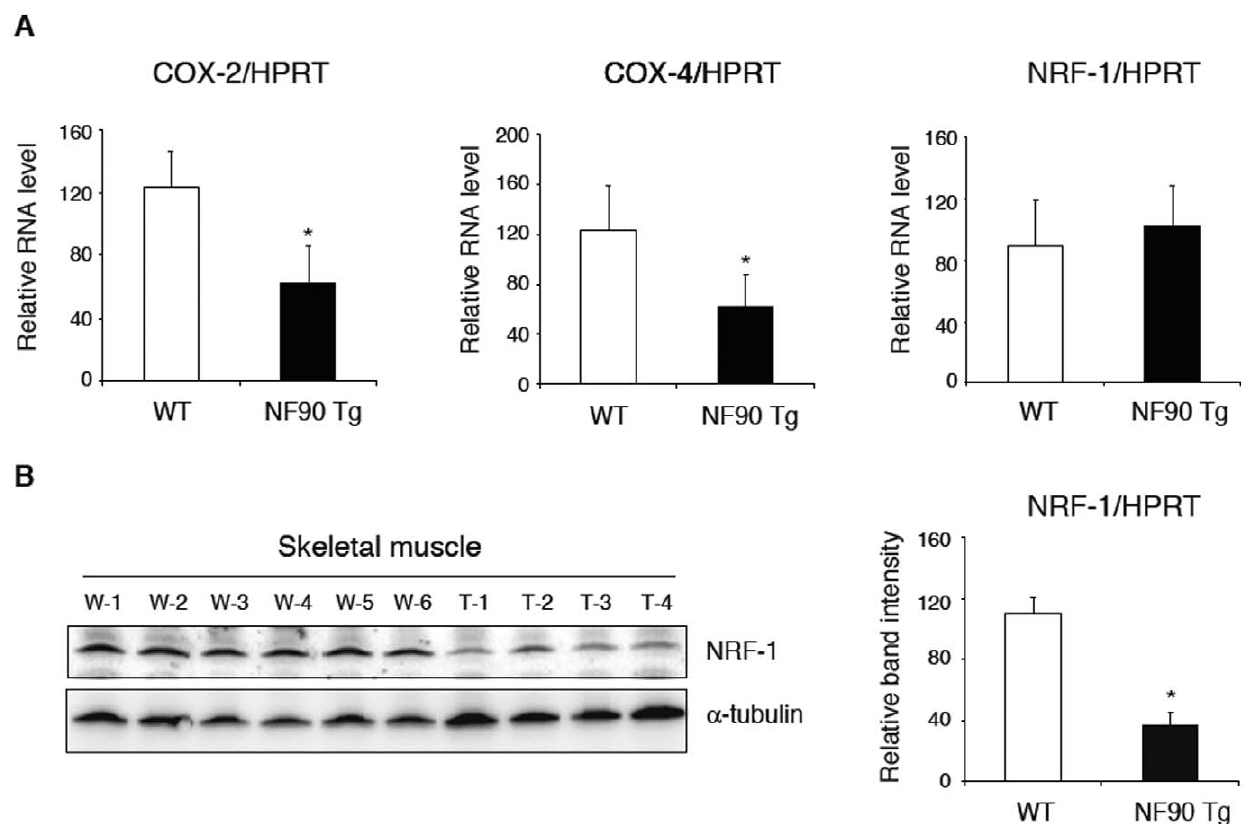
Figure 8. Expression analysis of mitochondria-related proteins, COX-2, COX-4 and NRF-1 in the skeletal muscles of WT and NF90 Tg mice. (A) RNAs isolated from skeletal muscles of WT (n=6) and NF90 Tg mice (line TG1) (n=4) were analyzed for expressions of COX-2, COX-4 and NRF-1 by RT-qPCR. HPRT was used as an internal control and for normalization of the data. Data are expressed as means 6 SD. *, p , 0.01 relative to WT by a two-tailed Student’s t test. (B) Immunoblot analysis of NRF-1 in tissue extractions of skeletal muscles of WT (n=6) and NF90 Tg mice (line TG1) (n=4). Anti- a -tubulin was used as loading control. W-1 to -6, WT; T1-1 to -4, NF90 Tg mice (line TG1). Intensities of specific bands in imunoblotting analysis were measured with a densitometer and are presented as a graph. Data are expressed as means 6 SD. *, p , 0.01 relative